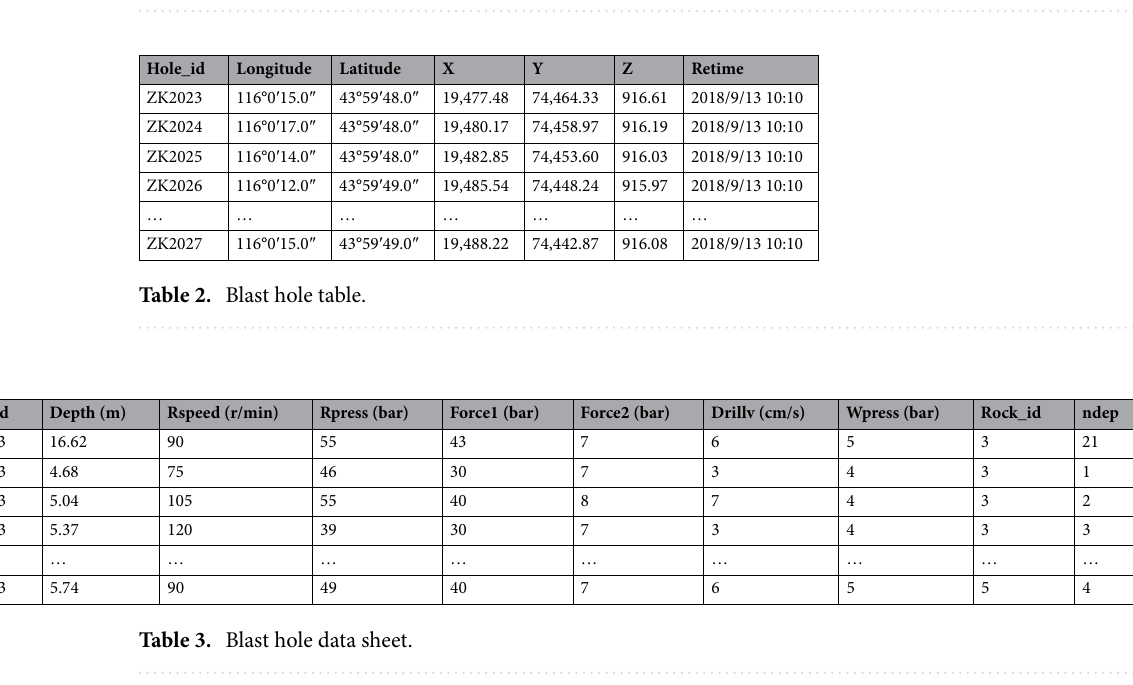
data tables in the database: blast hole table (hole), blast hole data table (data), and lithology table (rock) used to store data collected from intelligent drilling rigs. The relationship between these three data tables is shown in Fig. 1. The blast-hole table (hole) is associated with the blast-hole data table (data) via the hole_id, and the lithol- ogy table (rock) is associated with the blast-hole data table (data) via the rock_id.